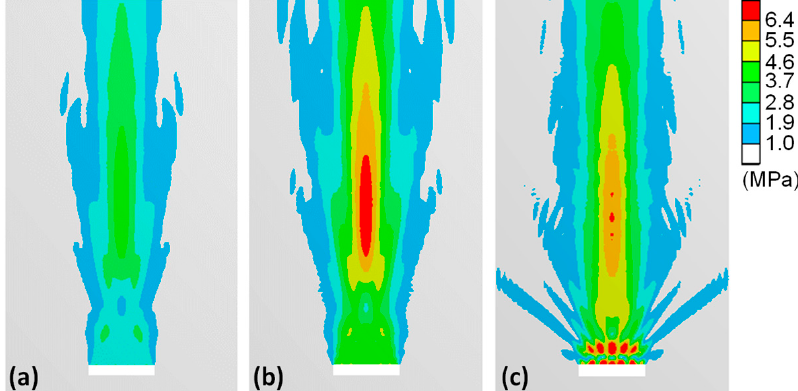
Figure 13. Comparison of acoustic pressure fields in the variation of electromechanical coupling; ( a ) lower ( − 5%) electromechanical coupling (43.5%), low acoustic impedance (8.5 MRayls), ( b ) maxi- mum electromechanical coupling (45.8%), and ( c ) lower ( − 5%) electromechanical coupling, denser piezoelectric volume (93%).